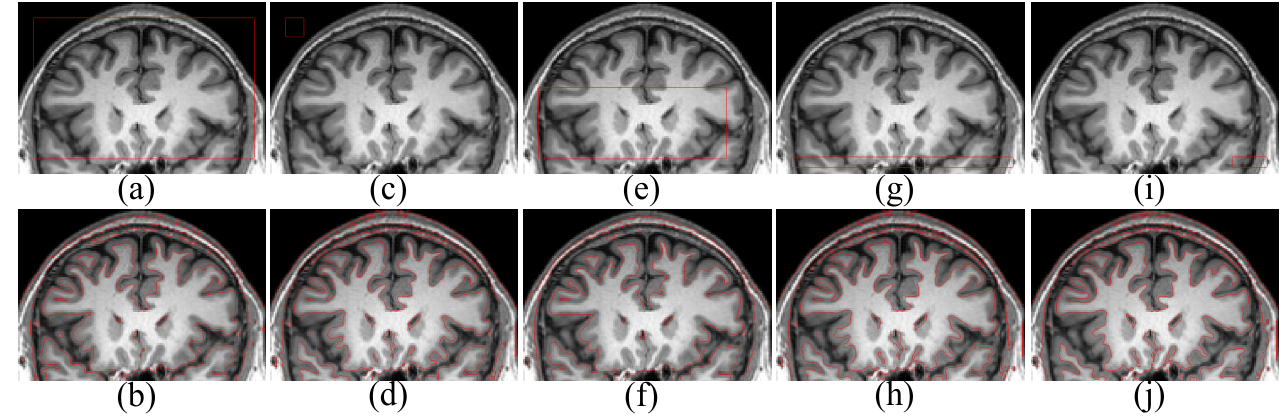
Figure 1. Segmentation results of our model with 5 different initial contours. ( a ) original image with initial contours; ( b ) the corresponding segmentation results of ( a ); ( c ) original image with initial contours, ( d ) the corresponding segmentation results of ( c ); ( e ) original image with initial contours; ( f ) the corresponding segmentation results of ( e ); ( g ) original image with initial contours; ( h ) the corresponding segmentation results of ( g ); ( i ) original image with initial contours; ( j ) the corresponding segmentation results of ( i ).